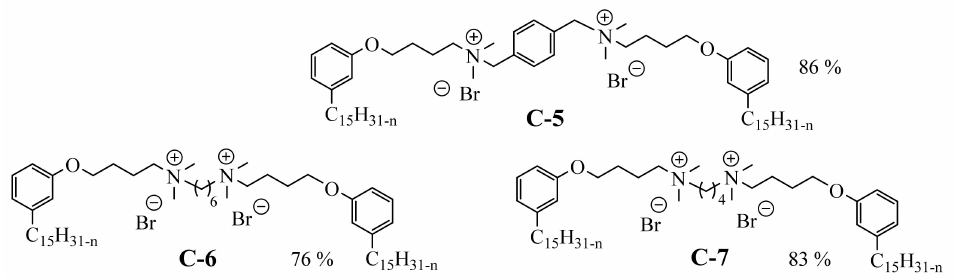
Figure 4. Gemini cationic surfactants obtained from cardanol (with reaction